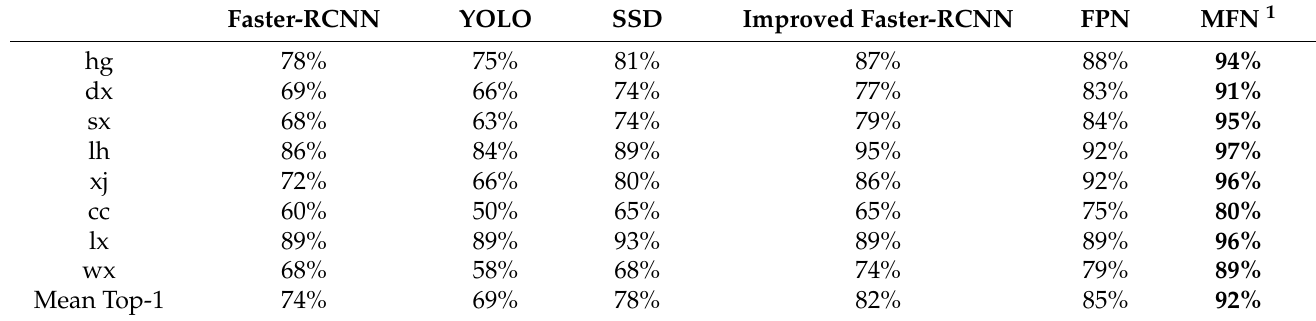
Table 4. Top-1 accuracy for each type of solder joint in different frameworks.